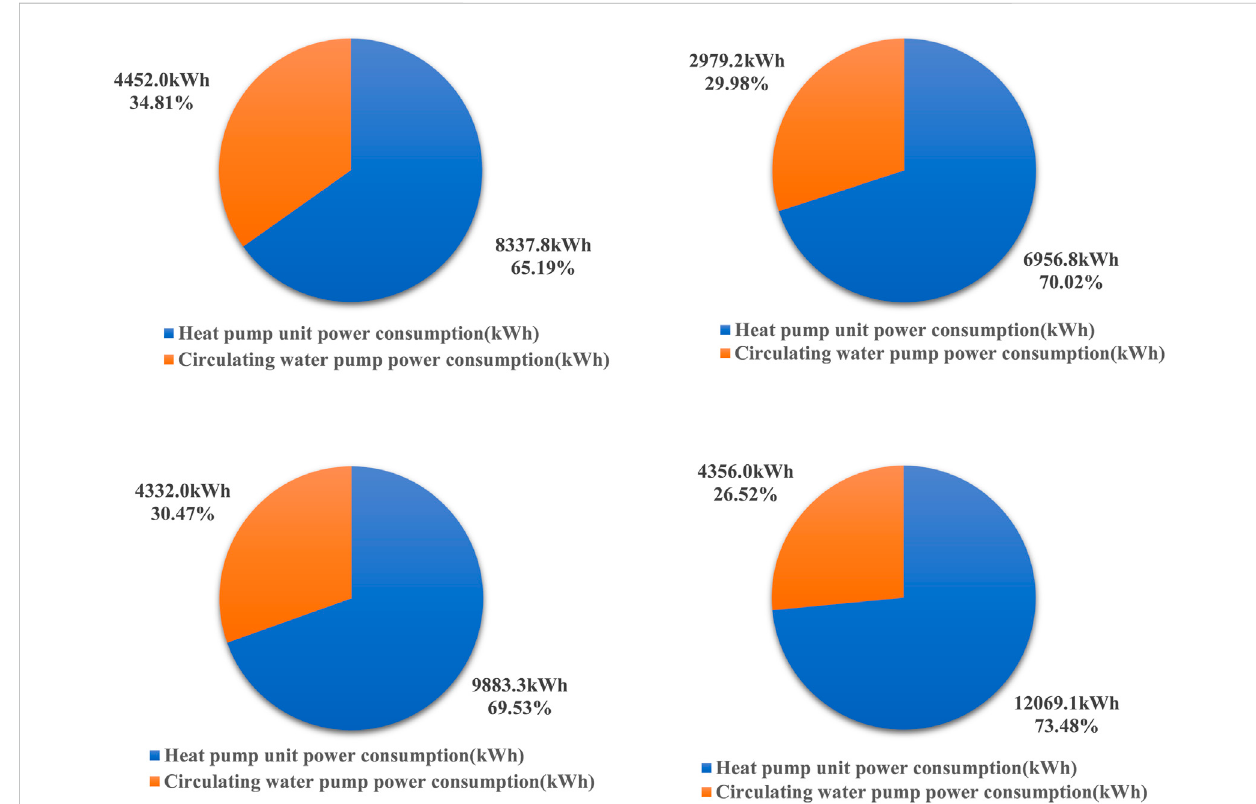
FIGURE 4 Powerconsumptioncompositionproportionofheatpumpsystem. (A) TheproportionofpowerconsumedbytheheatpumpsysteminCommunity A; (B) TheproportionofpowerconsumedbytheheatpumpsysteminCommunityB; (C) Theproportionofpowerconsumedbytheheatpumpsystemin Community C; (D) The proportion of power consumed by the heat pump system in Community D.